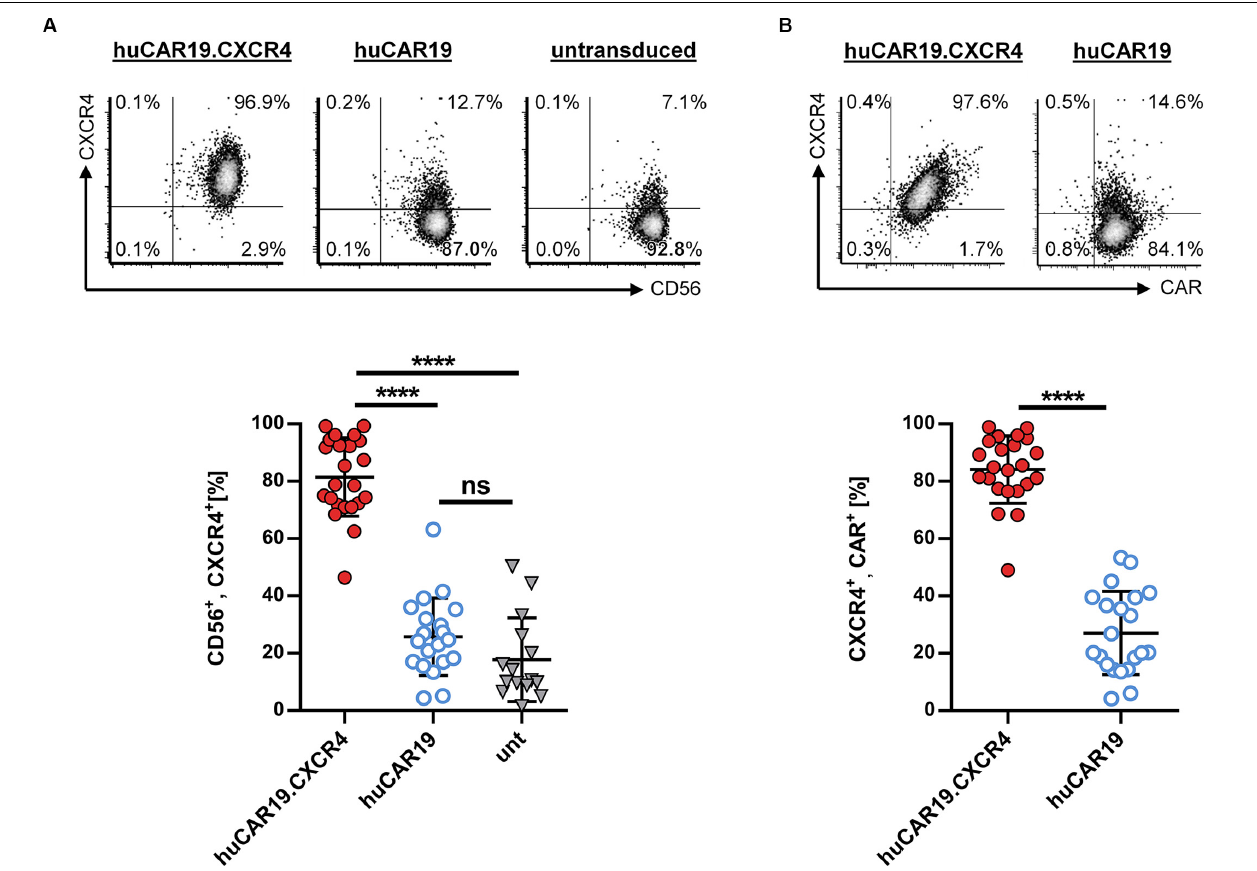
FIGURE 2 | CXCR4 overexpression on NK cells. Primary NK cells were transduced with huCAR19.CXCR4-LV or huCAR19-LV particles and analyzed for CXCR4 expression by flow cytometry 3 days post-transduction. Untransduced (unt) cells were cultured and analyzed in parallel. Each transduction experiment was performed at least 10 times with technical replicates. Three to four individually produced vector stocks were used. Mean value, SD, and significance are indicated. (A) Surface expression of CXCR4 on CD56-positive NK cells. Representative dot plots (upper panel) indicate the percentage of cells in each quadrant. Individual results of each experiment for CD56, CXCR4-double positive cells are shown in the lower panel. (B) Surface expression of CXCR4 on CD19-CAR-positive NK cells. Representative dot plots (upper panel) indicate the percentage of cells in each quadrant. Individual results of each experiment for CXCR4, CAR-double positive cells are shown in the lower panel. **** p < 0.0001; ns, not significant by unpaired t test. Characteristics of isolated, primary NK cells prior to transduction are shown in Supplementary Figure S1